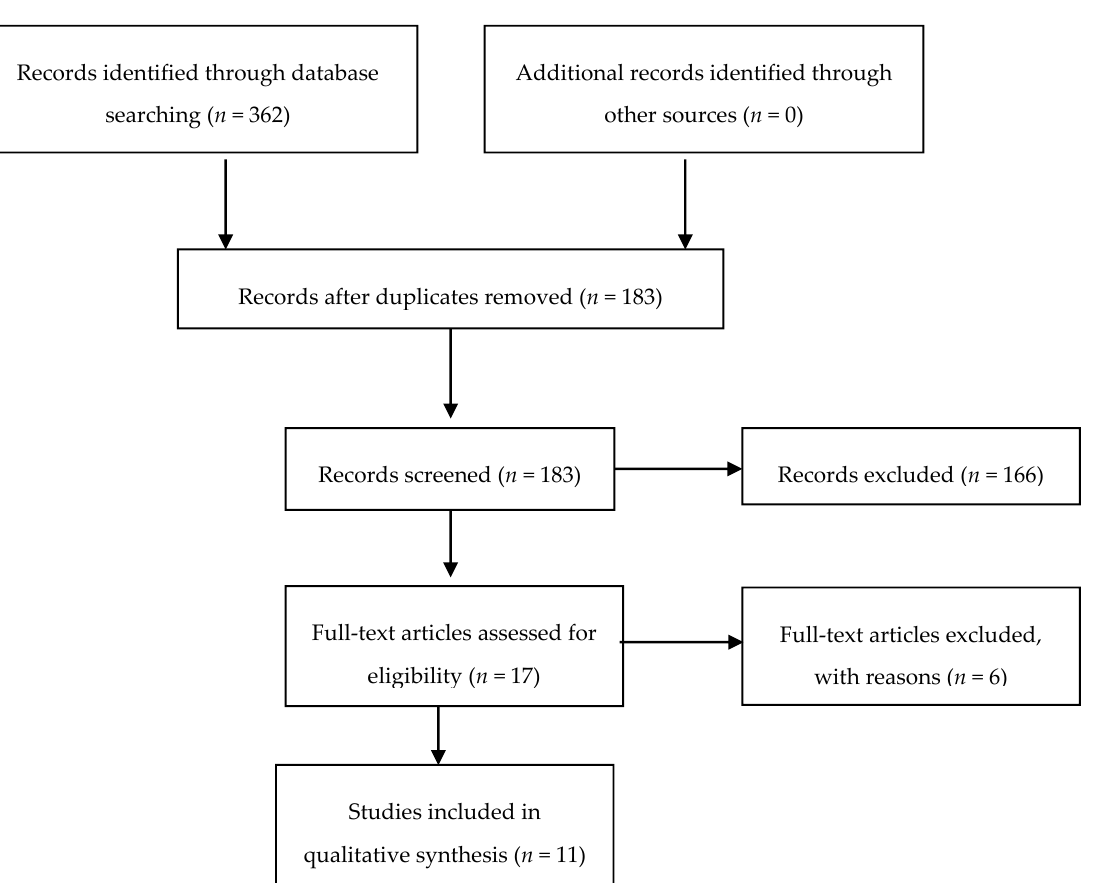
Figure 1. Flow diagram outlining the selection procedure to identify articles which were included in the systematic review of insomnia and assistive technologies in elderly people.